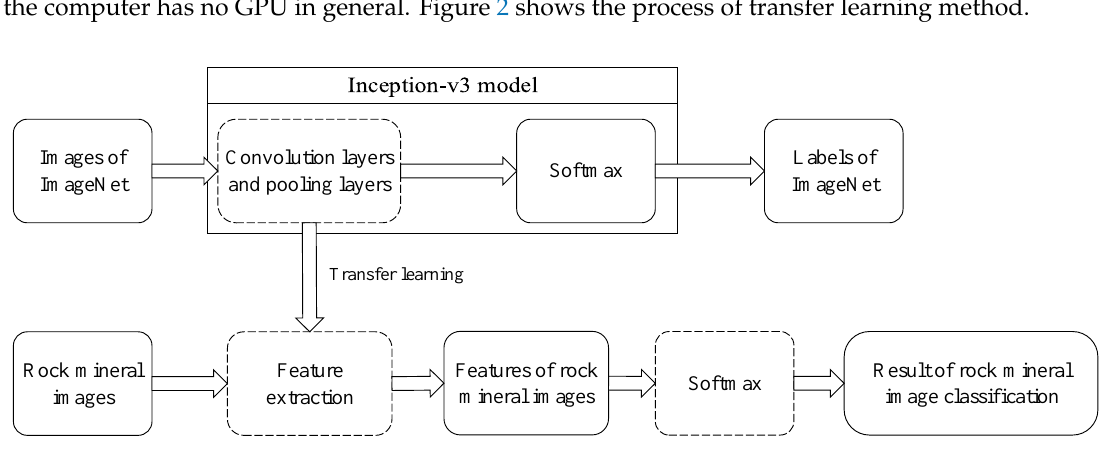
Figure 2. Transfer learning with Inception-v3.